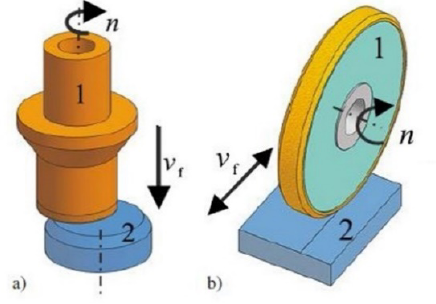
Fig. 2. Grinding strategies: a) face grinding b) lateral grinding